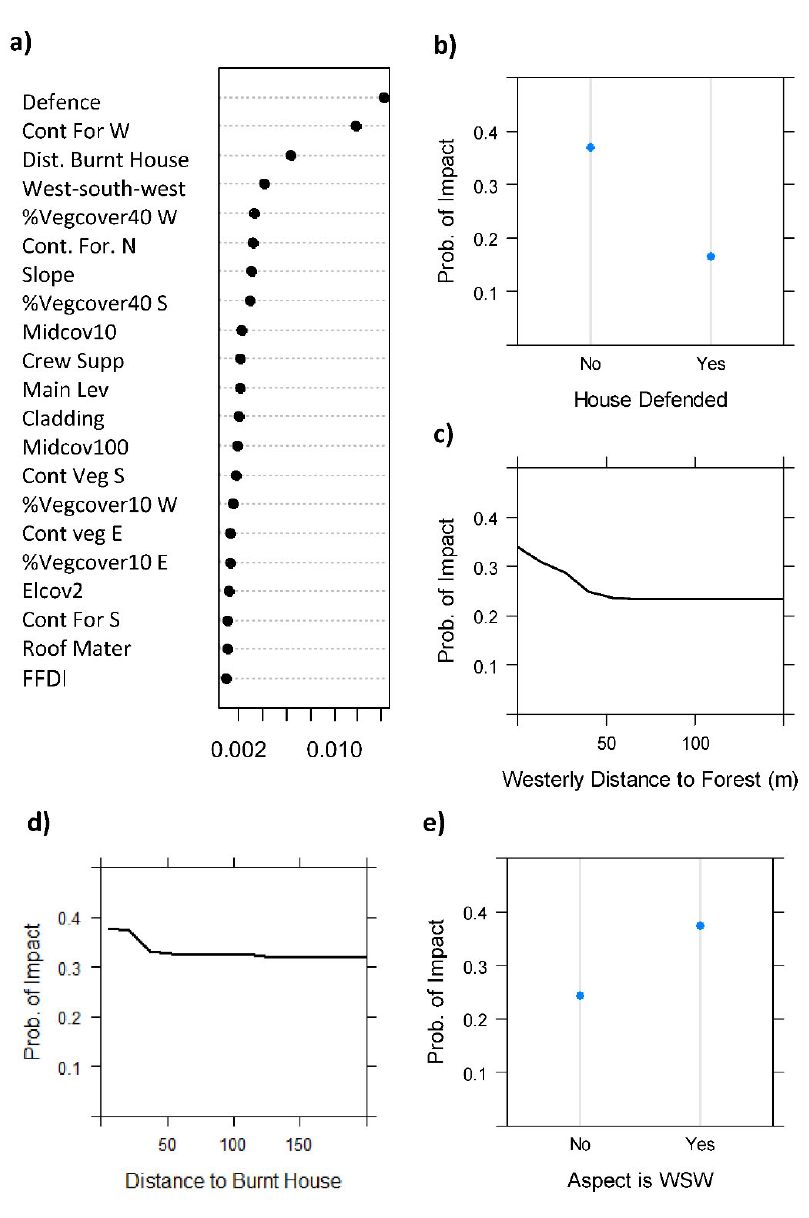
Figure 4. The Random Forest model for house impact comprising ( a ) the importance scores for the 21 best variables (scale is the loss of accuracy when each variable is dropped from the model) and ( b – e ) the partial effects plots for the four most important variables.